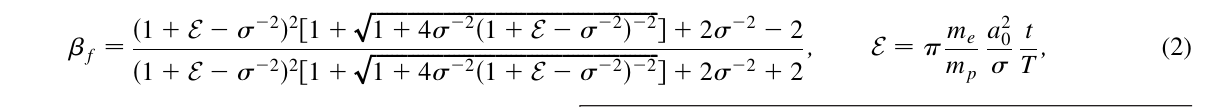
and 0 (top) and 0